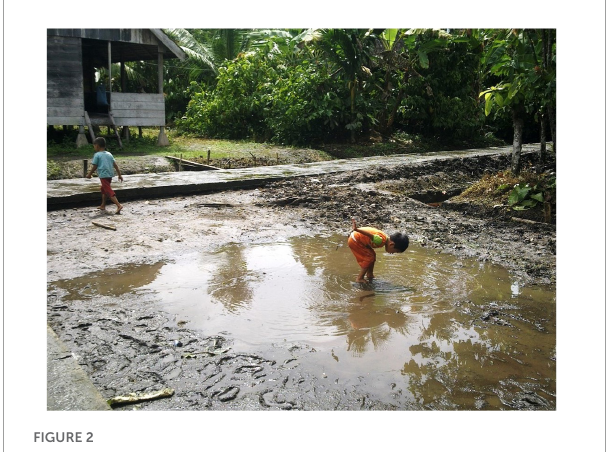
FIGURE2 Barefoot children play in the mud. A typical longhouse of Policoman (island of Siberut) is seen in the